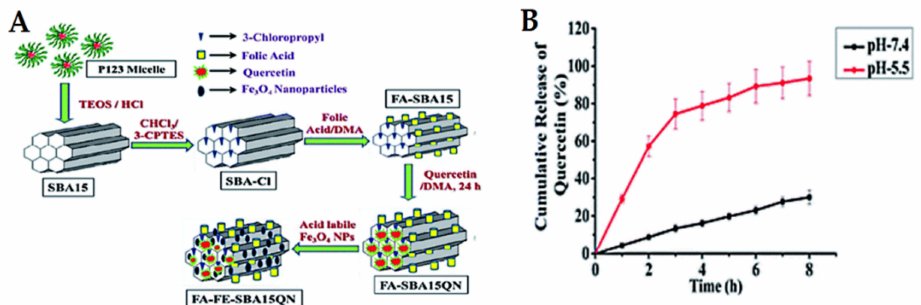
Figure 15. ( A ) Schematic representation of the delivery design for quercetin “FA-FE-SBA15QN”. ( B ) The release kinetics of quercetin from FA-FE-SBA15QN at different pH (7.4 and 5.5). The values are represented as the mean ± SEM. Reproduced with permission from [223], The Royal Society